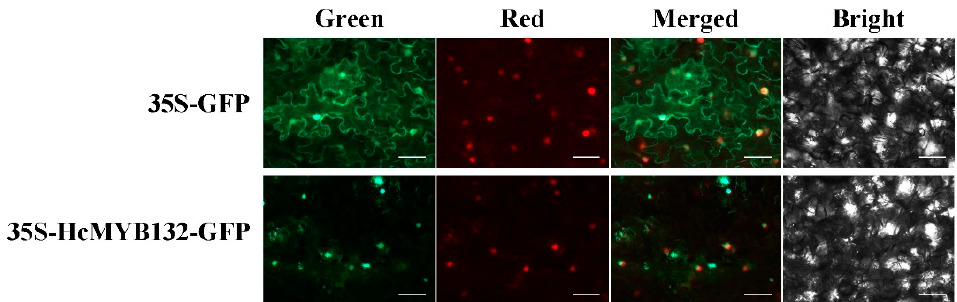
Figure 2. Nuclear localization of H . coronarium MYB132 protein in N . benthamiana leaves. Green: GFP fluorescence, red: mcherry as NLs marker, merged: merged green and red channels and bright field. Bars, 50 µM.